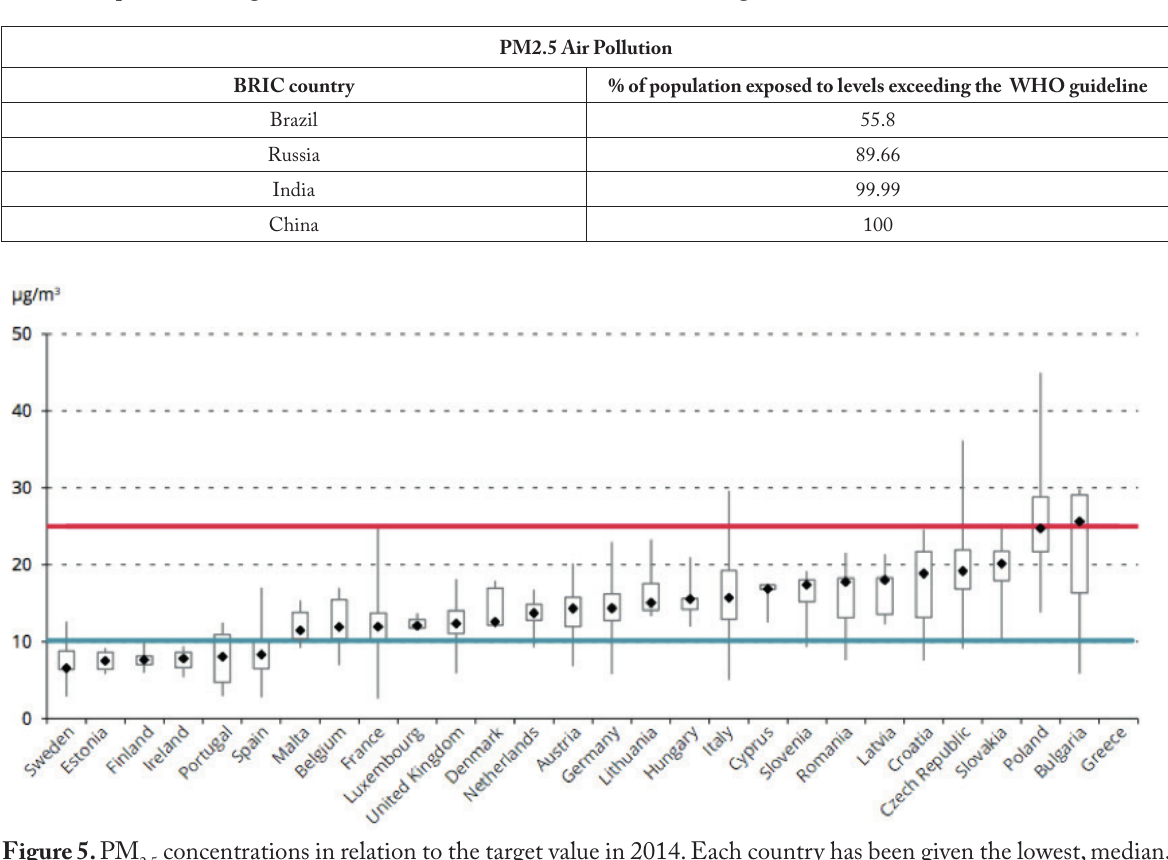
Figure 5. PM concentrations in relation to the target value in 2014. Each country has been given the lowest, median, 2.5 and highest values at the stations, with the box plots representing the 25th and 75th percentiles. The red line defines the target value set by EU legislation, and the blue line shows the WHO standard. (Source: European Environment Agency, 2016). Table 7. The relationship between air pollution (level of PM2.5) and economic development in 18 selected countries from all